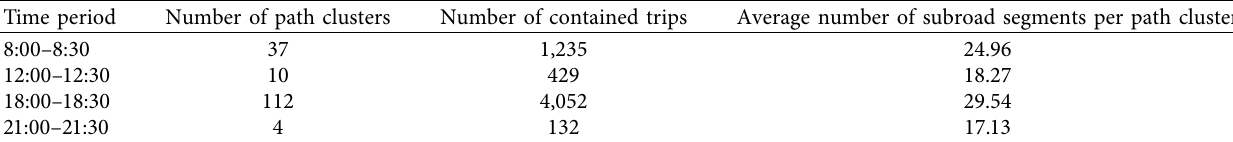
Table 4: Path clustering results of representative periods on September 9, 2019.